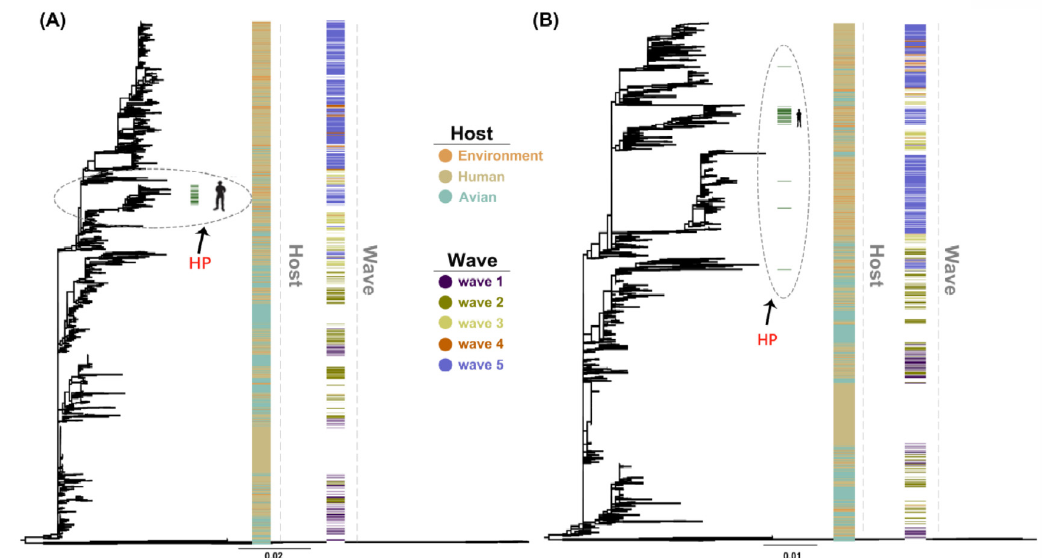
Figure 1. Maximum likelihood (ML) trees of H7N9 hemagglutinin (HA) ( A ) and neuraminidase (NA) ( B ) genes were reconstructed using RAxML (v8.2.10) with 1000 replications. The environment, human, and avian are represented in orange, beige, and cyan, respectively. Dark purple, olive green, light yellow, orange, and light purple correspond to waves 1 to 5. Grass green corresponds to high pathogenicity. HP: high pathogenicity.